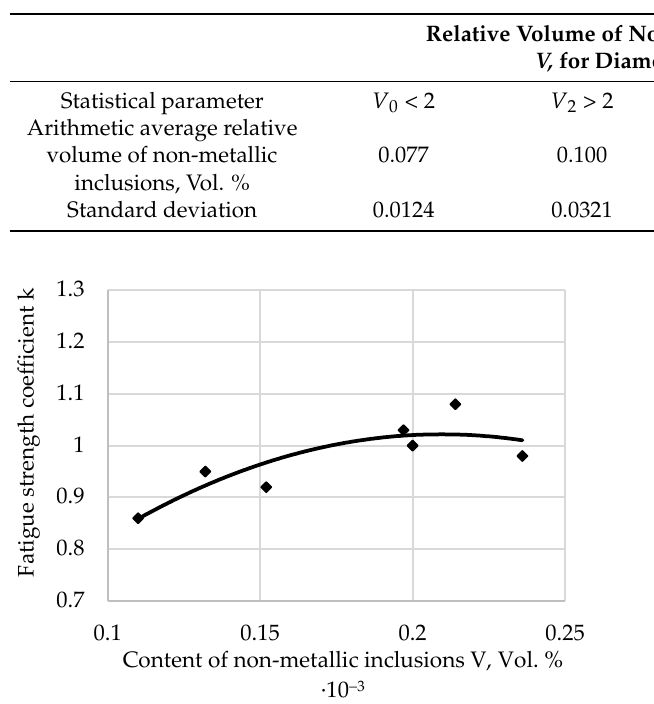
Table 5. Characteristics of non-metallic inclusions.